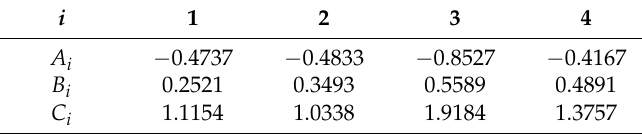
Table 8. Aggregated triangular fuzzy numbers G i = ( A i , B i , C i ).